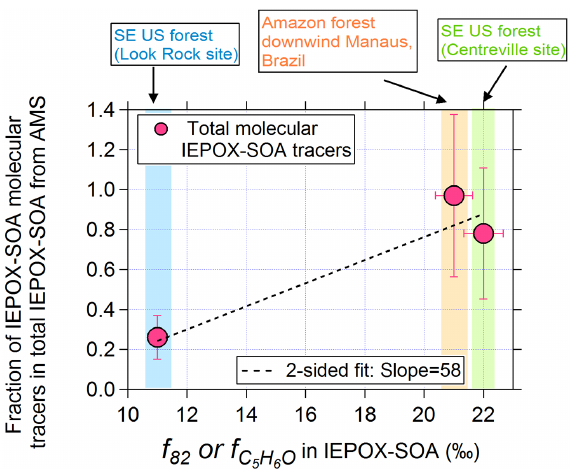
Figure 7. Scatter plot between total IEPOX-SOA molecular tracers (i.e., Methyltetrol + C5-alkene triols + IEPOX-derived organosul- fates and dimers) in IEPOX-SOA PMF and f IEPOX-SOA . Besides 82 SOAS, the other two data sets in the graph are from Budisulistiorini et al. (2015) and de Sá et al. (2015). The relative uncertainty value estimated for the SOAS study is applied to the other two data